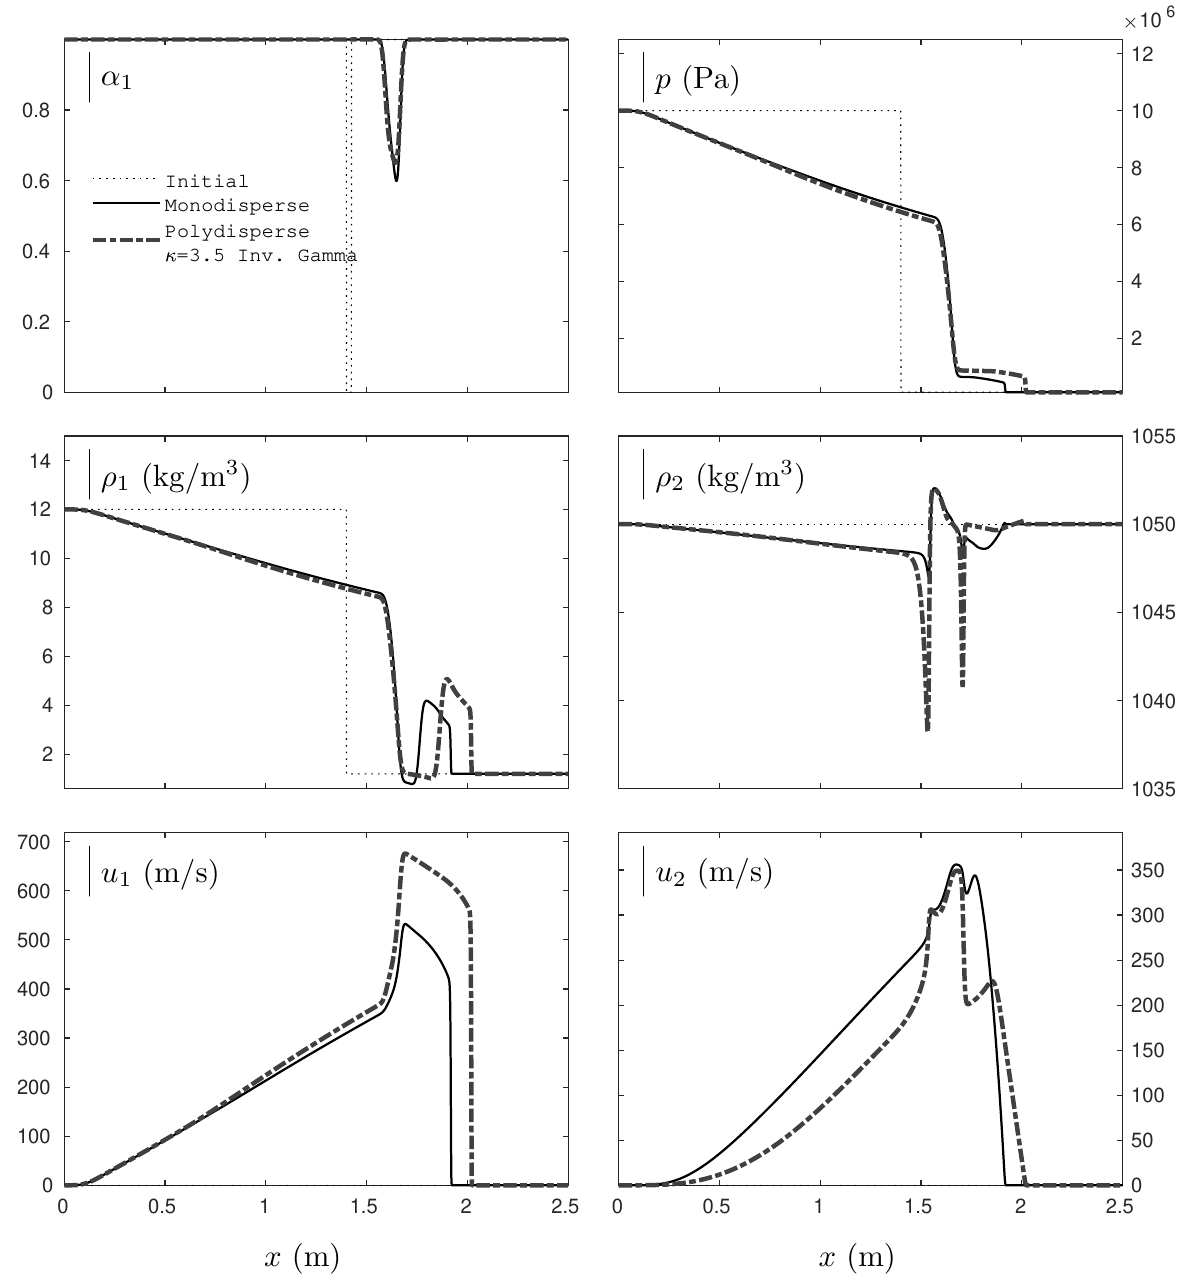
Figure 18. Simplified two-phase explosion test depicted in Figure 5. Comparison of the monodisperse Figure 18: Simplified two-phase explosion test depicted in Fig. 5. Comparison of the monosdisperse and polydisperse results. t = 0 = R t = 0 t =0 = and polydisperse results. The initial mean radius is the same for both computations R 2 The initial mean radius is the same for both computations R 2 = R t =0 = 30 µ m. For the polydisperse computation, the 2 2 30 µ m. For the polydisperse computation, the Inverse Gamma distribution is used with κ = 3.5. All Inverse Gamma distribution is used with κ = 3 . 5. All results are given at time t = 1 . 2 ms and are presented in terms of α 1 , p , results are given at time t = 1.2 ms and are presented in terms of α 1 , p , ρ 1 , ρ 2 , u 1 and u 2 for both ρ 1 , ρ 2 , u 1 and u 2 for both computations. Differences between the two solutions are visible. computations. Differences between the two solutions are